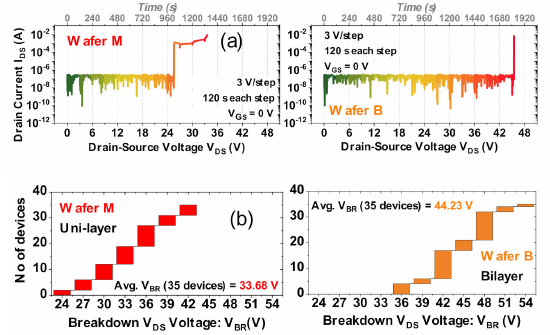
Figure 6. O ff -state drain step stress comparison at V GS = 0 V for Wafer M (uni-layer) and Wafer B (bilayer) devices. ( a ) drain-source current (I DS ) evolution during stress; ( b ) breakdown drain-source voltage (V BR ) distribution for 35 tested devices from each